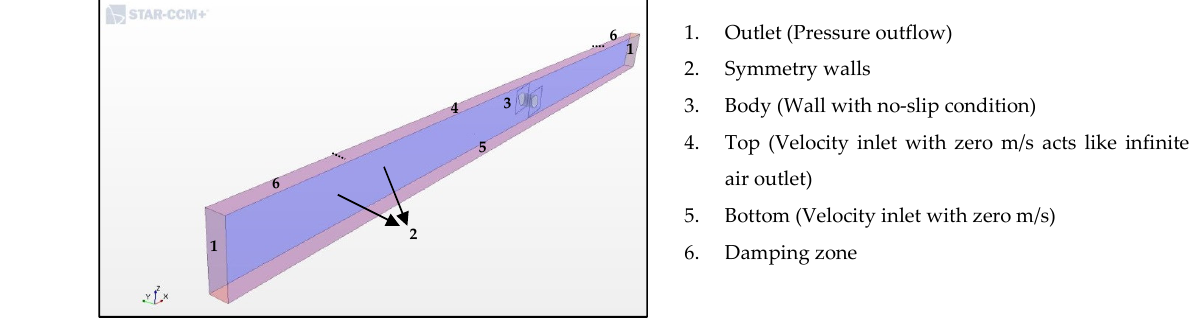
Figure 4. Computational domain with initial boundary conditions.